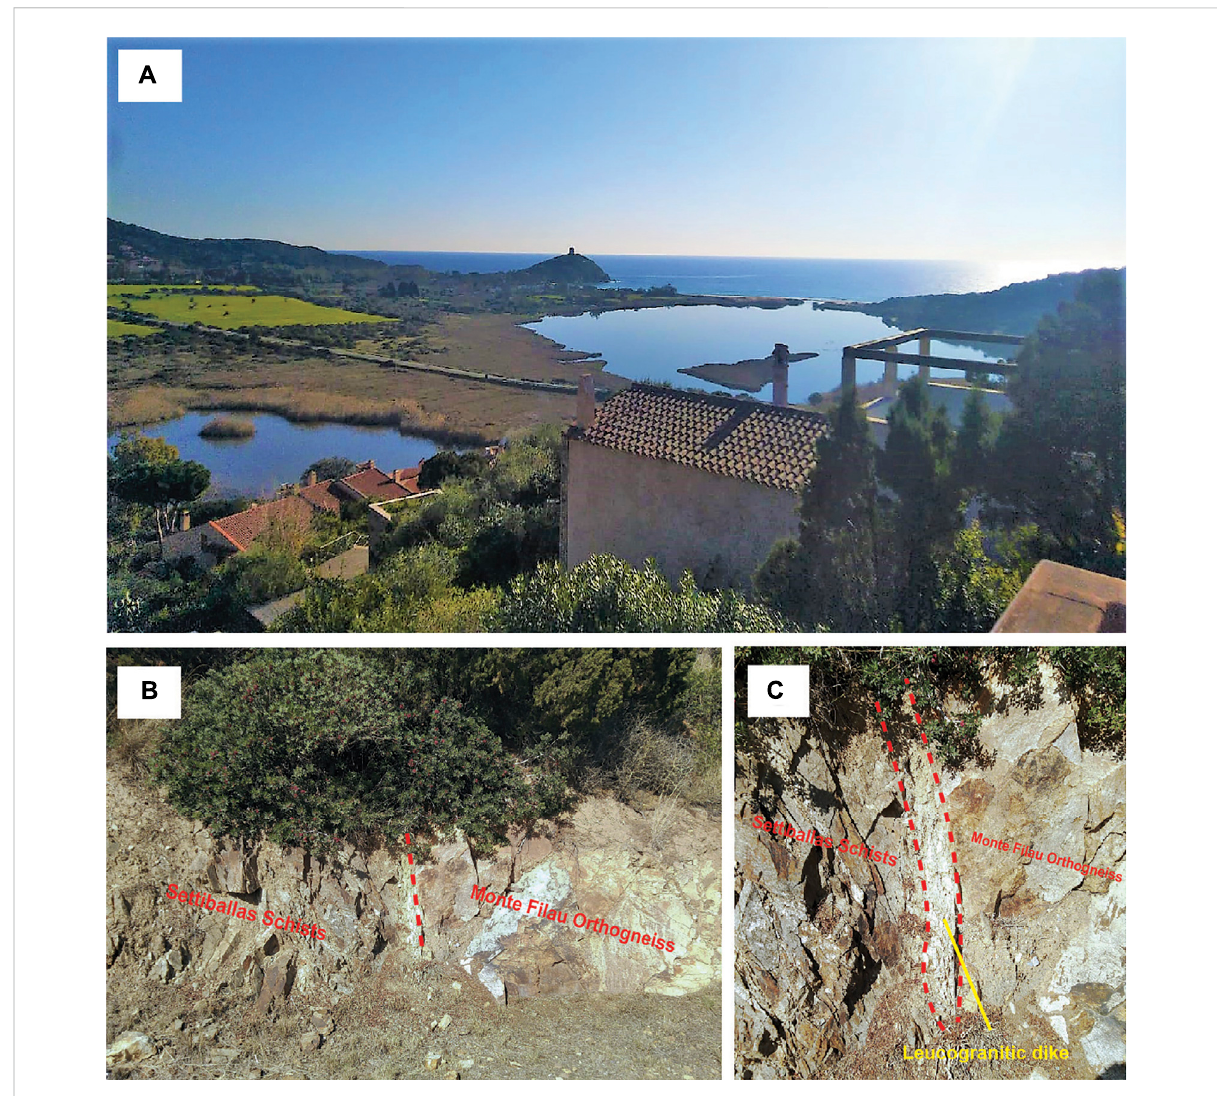
FIGURE 5 (A) View (toward SE) from the Settiballas hill of, from leftto right, thetower of Chia , the Sa Colonia Pond , and part of Mt. Cogoni hill; (B) contact between the Settiballas Schists and the Monte Filau orthogneiss at the Chia Laguna village; (C) detail of the contact in (B) , with a fractured late leucocratic dike intruding the